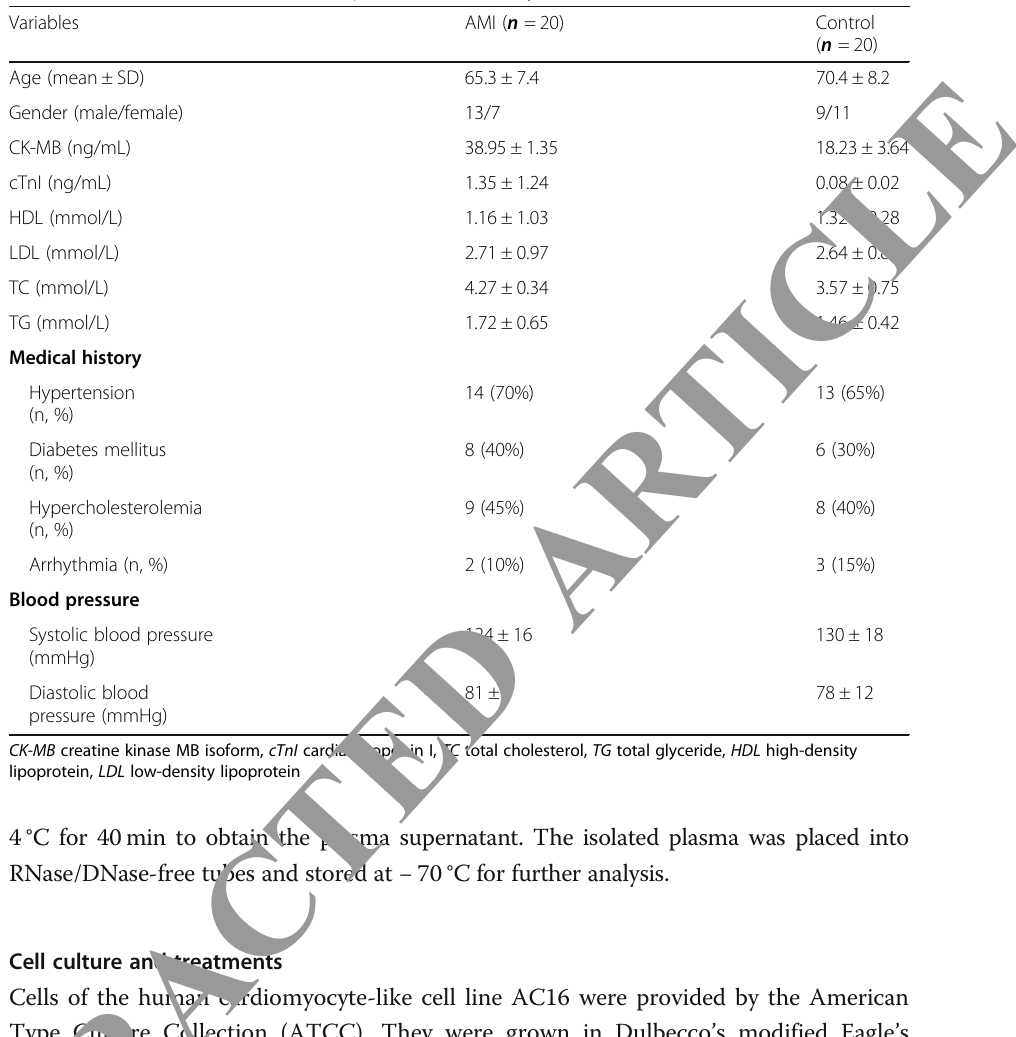
Table 1 Clinical characteristics of the patients and healthy control